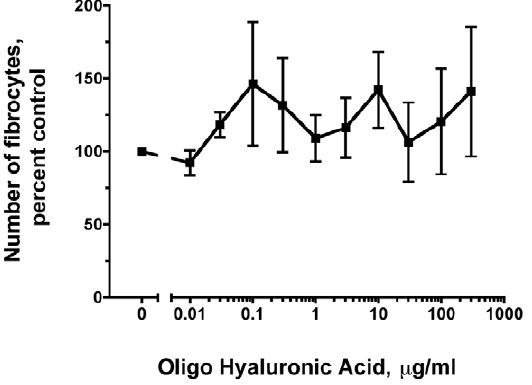
to be due to differential internalization of high and low molecular weight hyaluronic acids by purified monocytes.